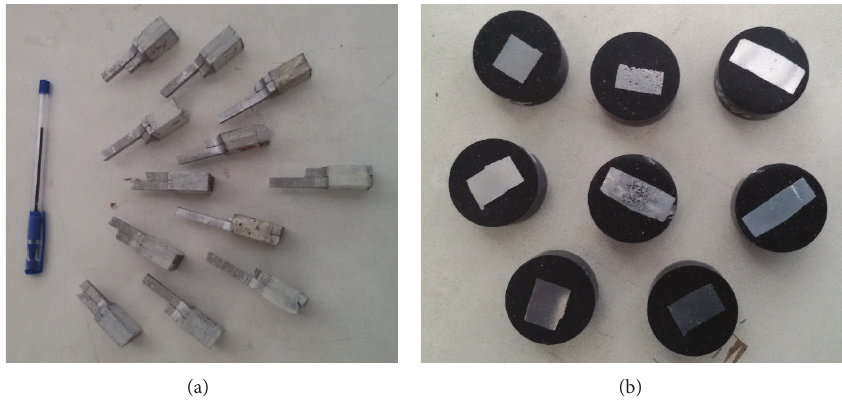
Figure 3: Tested specimens (a) UTS and YS (b) hardness and